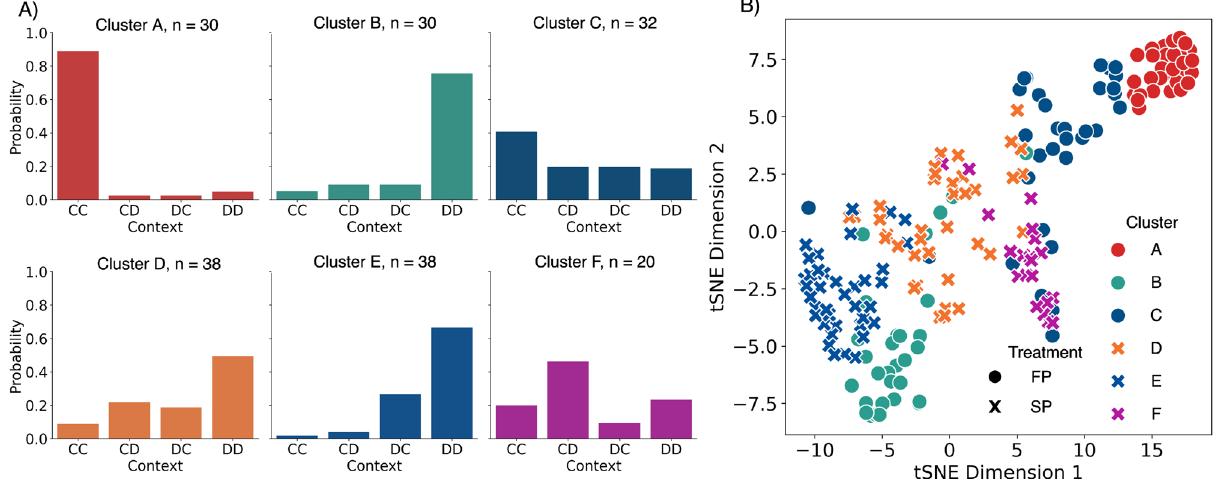
Figure 3. Probability of cooperation given each context per cluster (using K-Means). ( A ) The top row shows the context composition of each cluster in the FP treatment, the bottom row does the same for each SP cluster. ( B ) tSNE visualization of the different clusters A–F.